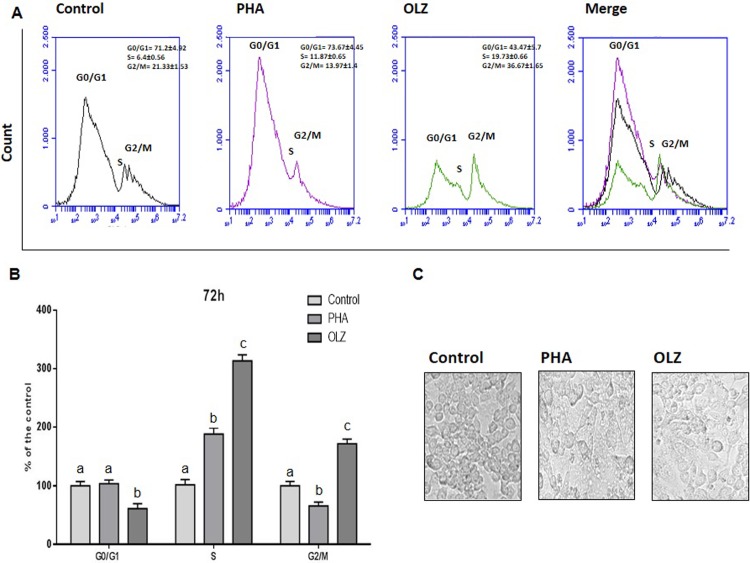
Comparison of cell cycle determined by flow cytometry analysis among RAW macrophages 72 h cultures exposed OLZ (OLZ) at 0.03 μg/mL concentration and to phytohaemagglutinin (PHA), an natural antigen that trigger inflammatory macrophages activation.(A) Representative graphics with cell phases: (G0/G1 = gap 1; S = synthesis; G2/M = gap2 and mitosis). (B) % of cells the control in at each stage (G0/G1 = gap 1; S = synthesis; G2/M = gap2 and mitosis) of the cell cycle compared by One-way analysis of variance (ANOVA), followed by the Tukey post hoc test. The different letters (i.e., A, B, C, D, E, F) indicate statistical differences in each treatment at p < 0.05. (C) Monolayer culture pattern of RAW macrophages microscopic optic analysis (×40, scale bar = 20 μm) in control (C) cells and cells exposed to OLZ and PHA. No-activated C-cells presented higher frequency of spheric cells typical of monocytes. Cells PHA and OLZ exposed presenting a macrophage spreading pattern that is observed in inflammatory-activated cells.